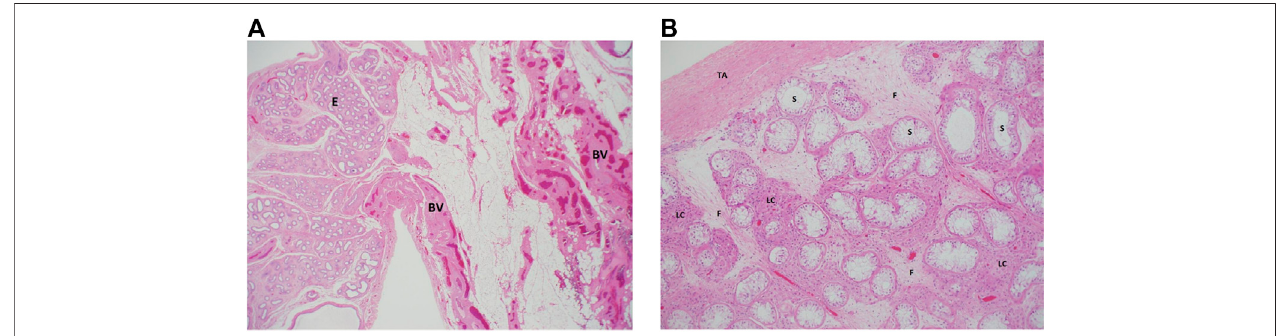
FIGURE 1 | Histologic examination of the proband ’ s testicular biopsies. (A) Left testes: a low magni fi cation (×20) from the surgical specimen of the left “ testis ” where epididymal tissue (E) is seen along with adjacent fatty tissue that is rich in blood vessels (BV). Note the total absence of any testicular tissue. (B) Right testis: an intermediate magni fi cation (×100) image from the right testis showing seminiferous tubules (ST) that lack germ cells (lined by Sertoli cells only). The interstitium between the tubules shows clusters of hyperplastic Leydig cells (lLC) and fi brosis (F) secondary to tubular atrophy. TA, tunica albuginea. Both sections were stained using hematoxylin and eosin staining.